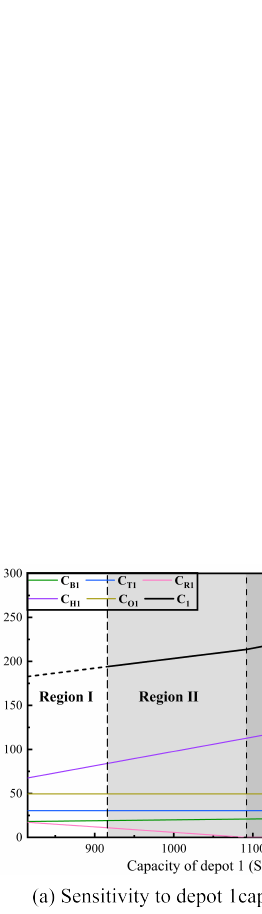
Figure 6. Sensitivity analysis of inventory capacity.